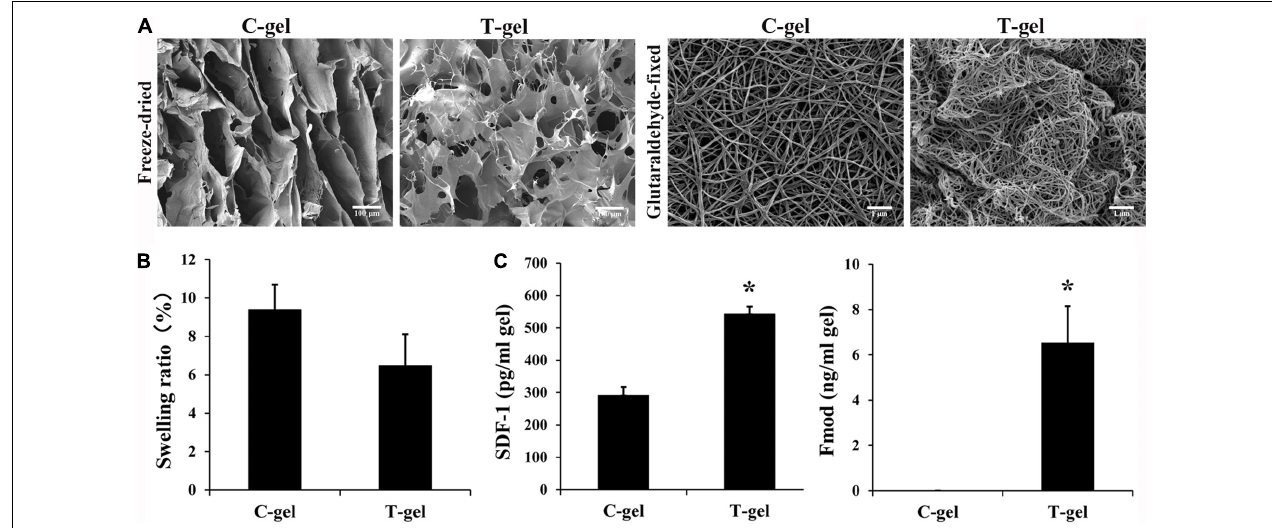
FIGURE 4 | Analysis of microstructure, retained bioactive factors and equilibrium swelling properties of the C-gel and T-gel. (A) Representative SEM micrographs of the C-gel and T-gel. Scale bar = 100 µ m for freeze-dried samples and Scale bar = 1 µ m for glutaraldehyde-fixed samples. (B) Swelling ratios of the C-gel and T-gel.